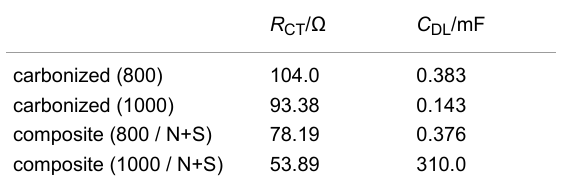
Table 4: Values for the charge transfer resistance and the double- layer capacity received by fitting the impedance data with correspond- ing circuit model in Figure 7 and converting the CPE parameters following Hirschorn and co-workers